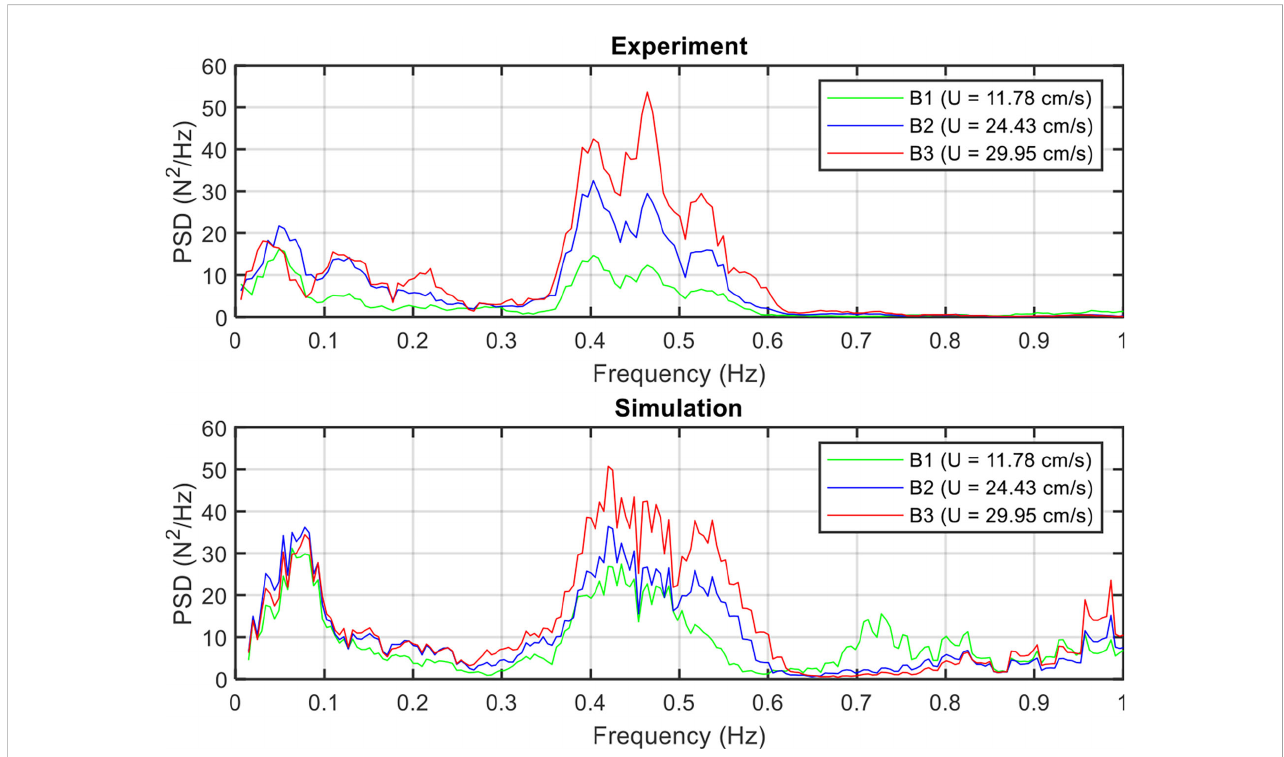
FIGURE 14 In fl uence of the current velocity on the power spectral density of the mooring force under the mooring line failure of a net cage in irregular waves and currents.